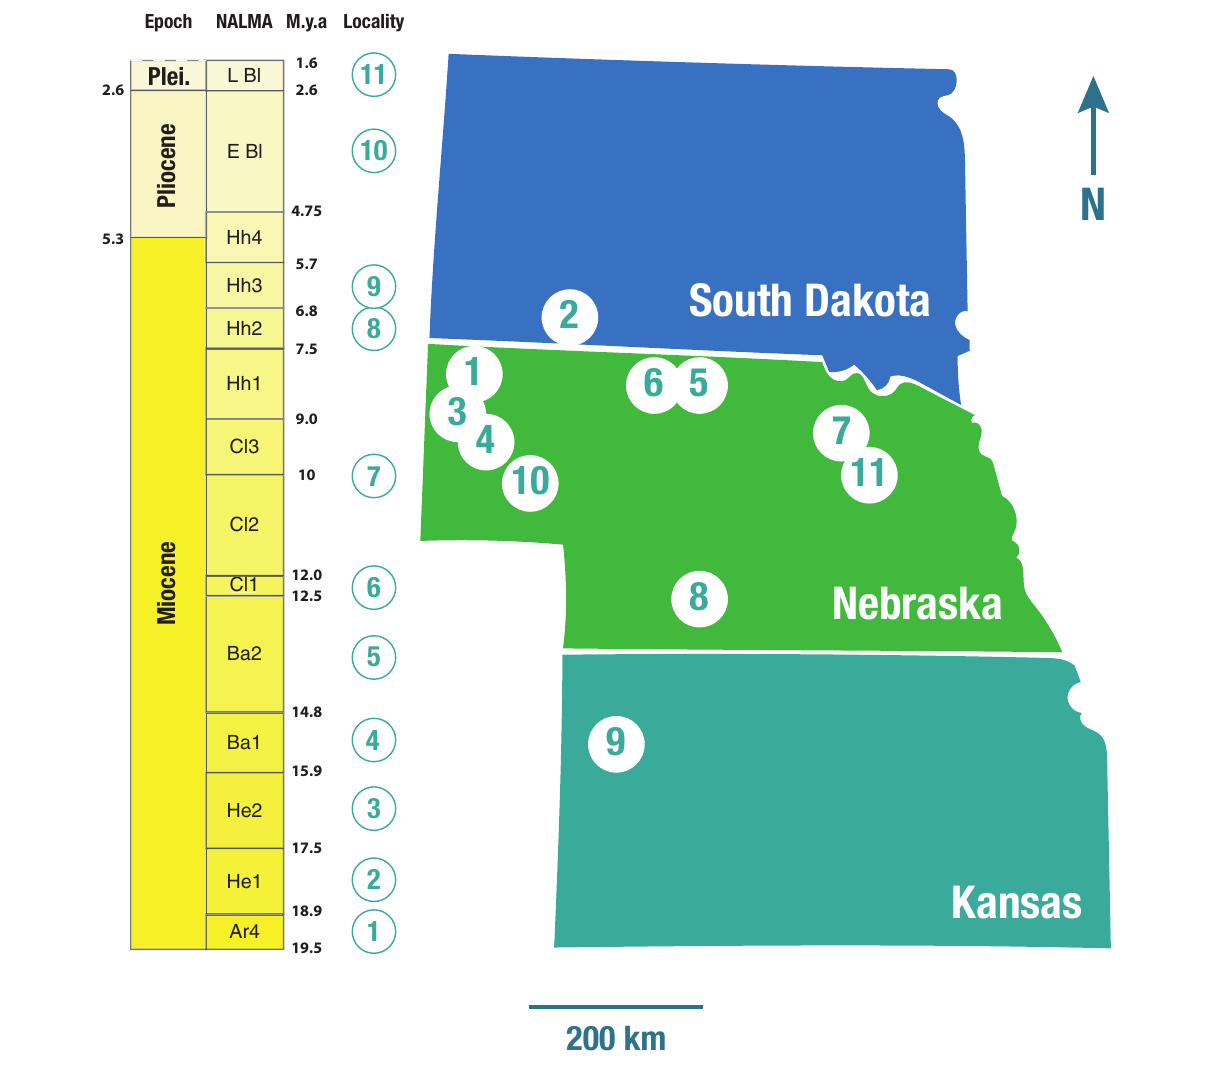
FIGURE 2 | Geographic distribution of the ungulate faunas used in this study: 1-Morava Ranch Quarry, Marsland Formation (13 ungulate taxa); 2-Flint Hill Local Fauna, Batesland Formation (16 ungulate taxa); 3-Thomson Quarry, Sheep Creek Formation (26 ungulate taxa); 4-Echo Quarry, Olcott Formation (25 ungulate taxa); 5-Norden Bridge Quarry Local Fauna, Valentine Formation (29 ungulate taxa); 6-Burge Quarry Fauna, Valentine Formation (21 ungulate taxa); 7-Blue Jay Quarry, Ash Hollow Formation (14 ungulate taxa); 8-Cambridge Local Fauna (Ft-40), Ash Hollow Formation (16 ungulate taxa); 9-Edson Quarry Fauna, Ogallala Formation (13 ungulate taxa); 10-Broadwater Local Fauna, Broadwater Formation (6 ungulate taxa); 11-Big Springs Local Fauna, Long Pine Formation (9 ungulate taxa). NALMA, North American Land Mammal Age; M.y.a., million years ago; Plei., Pleistocene; Ar, Arikareean; He, Hemingfordian; Ba, Barstovian; Cl, Clarendonian; Hh, Hemphillian; E Bl, Early Blancan; L Bl, Late Blancan. For a full breakdown of the ungulate taxa in each fauna, please refer to Supplementary Information